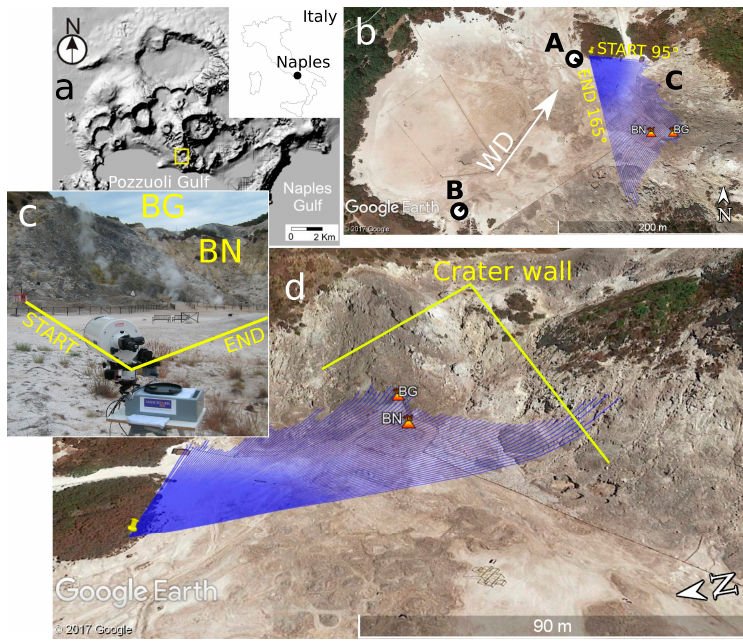
Figure 1. Field measurement situation. ( a ) Location of Solfatara; ( b ) Measurement geometry showing the laser beam paths in blue (rays) with start and stop scanning angle and prevailing wind direction WD during measurement. The circles at A and B depict positions and viewing directions of the camera. The two main vents Bocca Grande (BG) and Bocca Nuova (BN) are marked; ( c ) Scanning geometry of the remote sensing platform LARRS while at position A, with telescope aligned with start angle; ( d ) 3D view of the scanning geometry. The apparent bending of the beam paths results from projecting them onto the